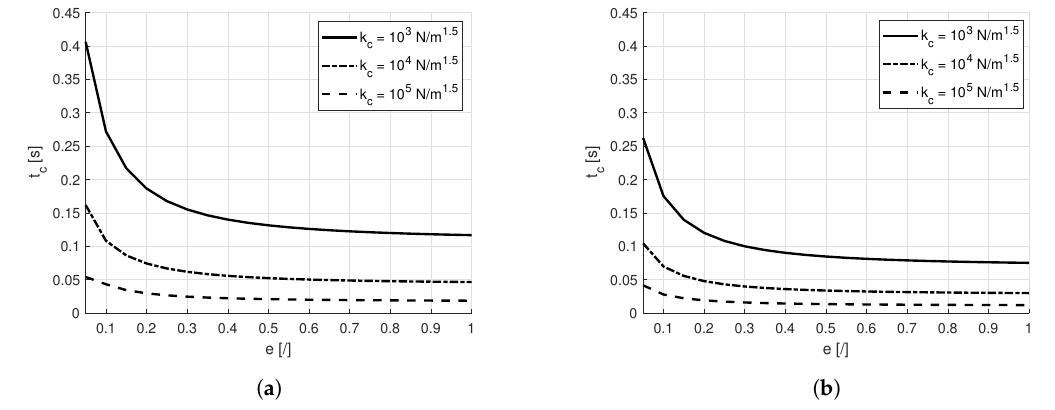
Figure 7. Influence of k c and e on contact duration. ( a ) Limit case of Figure 4a; ( b ) limit case of Figure 4b.